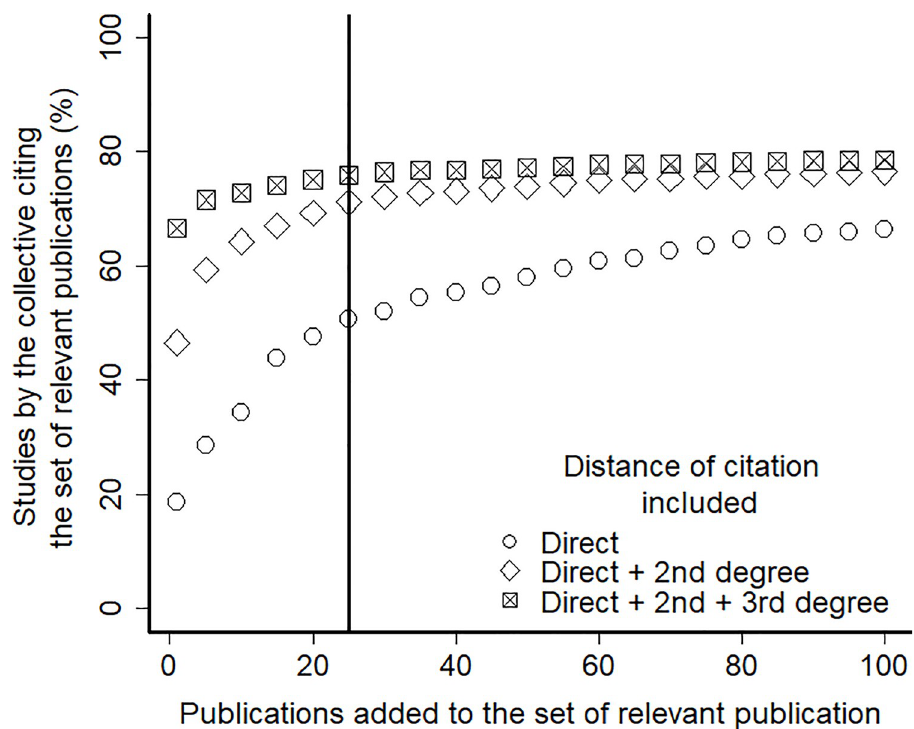
Fig 2. Asymptotic relationship between the size of the relevant publication set and the percentage of studies authored by the defined collactive of scientists that cites the relevant publication set. Direct citation distance considers only studies that cite the relevant publication directly. 2nd degree citations consider studies that directly cited the relevant publication and also studies that cited the studies that cited the relevant publications directly, the same logic applies to the 3rd degree citation. The vertical line indicates the threshold above which the percentage of studies of the collective that cite the set of relevant publications tends to stabilize, meaning that the addition of more relevant publications to the set does not aggregate more citations from the